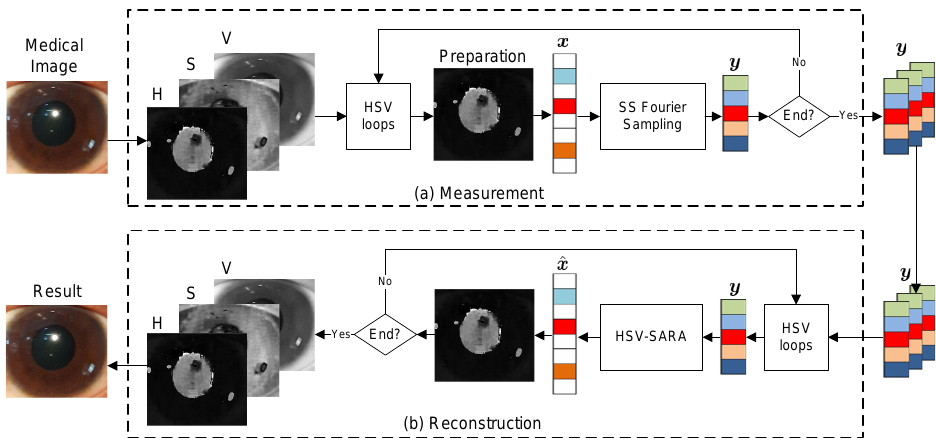
Figure 3. The proposed